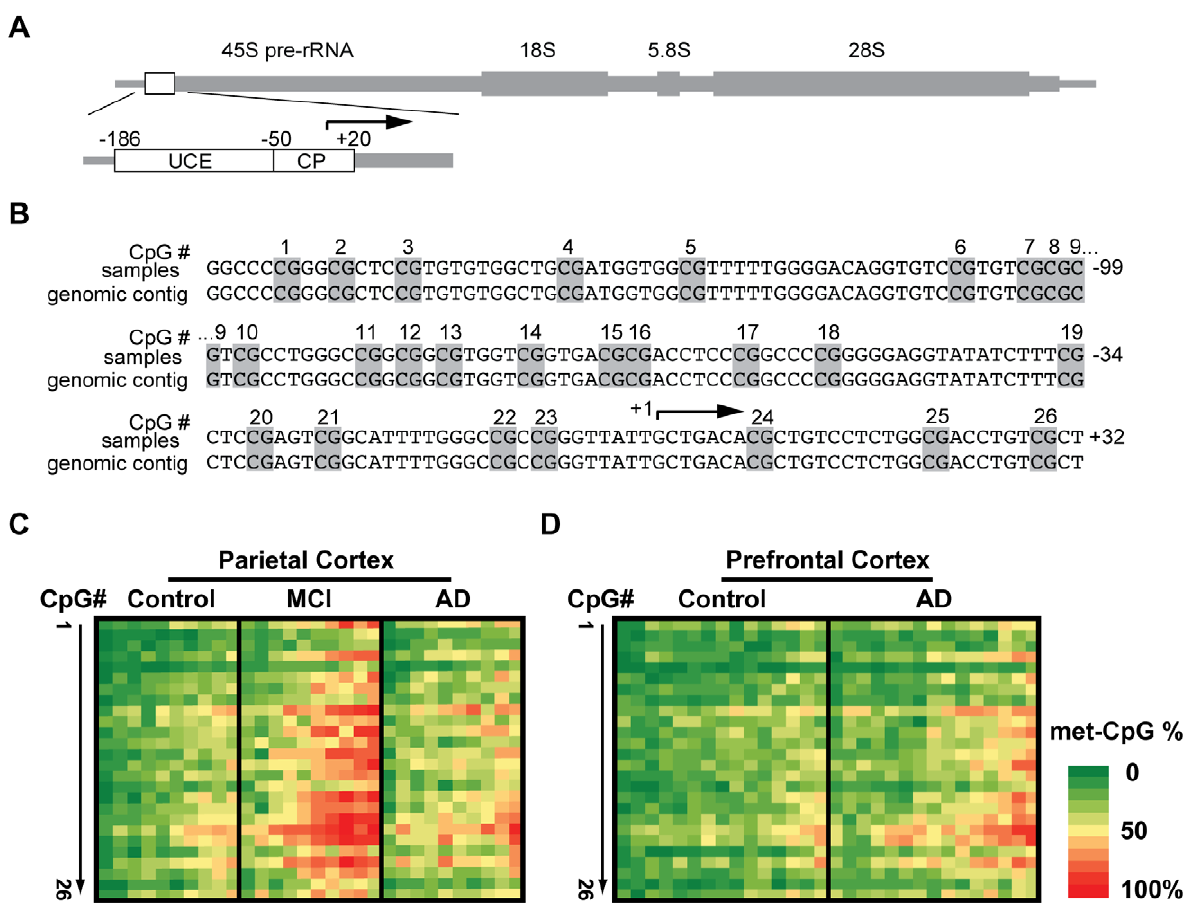
Figure 1. Methyl-cytosine (mC) mapping of the rDNA promoter region. A , The rDNA gene unit. The location of the promoter region that was selected for bisulfite mapping of methyl cytosines is indicated by a box. That analyzed region included the Upstream Control Element (UCE) and the Core Promoter (CP) which contain 26 CpG methylation sites that are critical for epigenetic regulation of nucleolar transcription (for more detail, see Fig. S1). B . Nucleotide sequence of the human rDNA promoter. The numbers on the right indicate positions relative to the transcription start site at position + 1 (arrow); Potentially methylated CpG dinucleotides are marked grey and numbered. C , Bisulfite sequencing analysis of parietal cortex from control-, MCI-, and AD individuals (n=10 for each group). D . Bisulfite sequencing analysis of prefrontal cortex from control-, AD individuals (n=15 for each group). In C–D, each column represents one individual. Rows represent each of the potentially methylated 26 CpG sites in the rDNA promoter in 5 9 to 3 9 orientation. The data (% methylation for a given CpG) are from analyzing 20 unique clones for each subject.